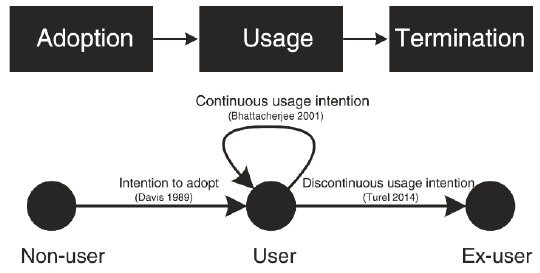
Figure 1. Life cycle of an IS [95].